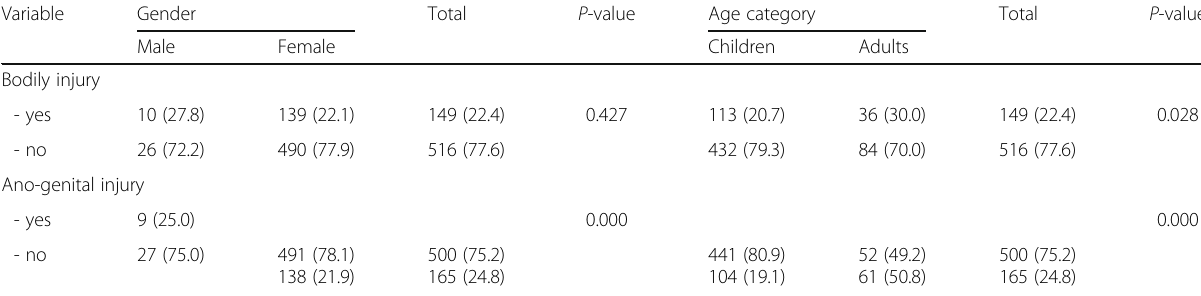
Table 5 Association of bodily injury and ano-genital injury with gender and age category